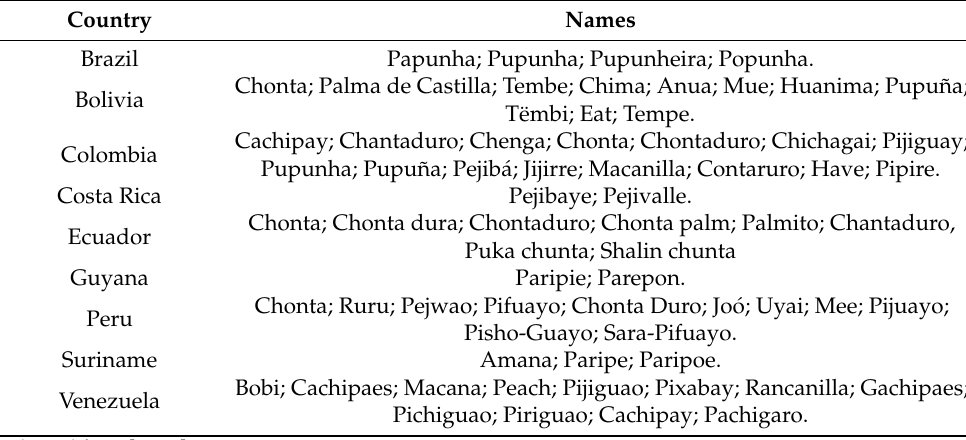
Table 1. Common names of Bactris gasipaes according to